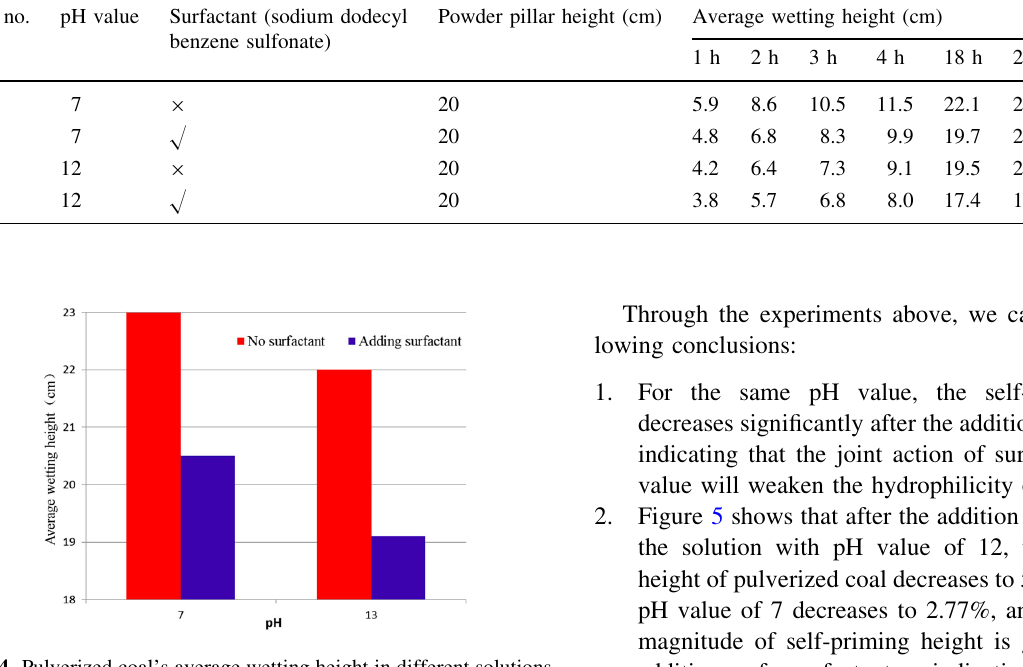
Fig. 5 Pulverized coal’s average wetting height varying with the time in different